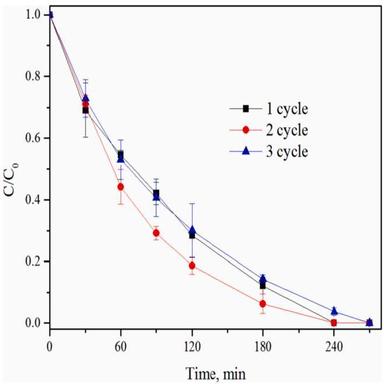
Kinetic of AO7 dye degradation in the presence of 1 PLACHLA + TiO2 sample (given for three cycles of dye degradation, plotted as C0 – initial concentration of dye and C – measured concentration of dye vs. time).